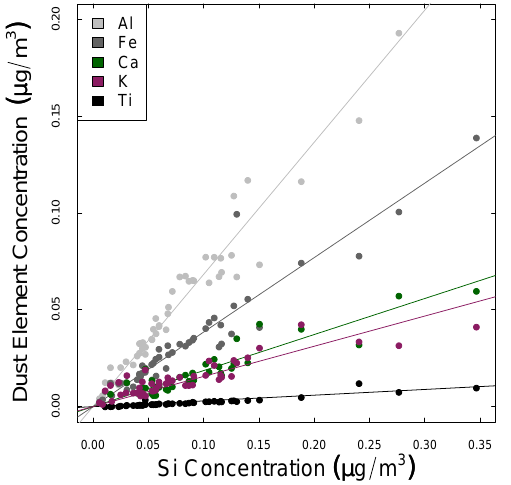
Fig. 3. Comparison of concentrations of several dust markers (Al, Fe, Ca, K, Ti) with Si for all above detection limit 12 h samples col- lected during the project. All 5 dust markers had strong correlations with Si and slopes of 0.68, 0.38, 0.19, 0.16, and 0.03 for Al, Fe, Ca, K, Ti, respectively.